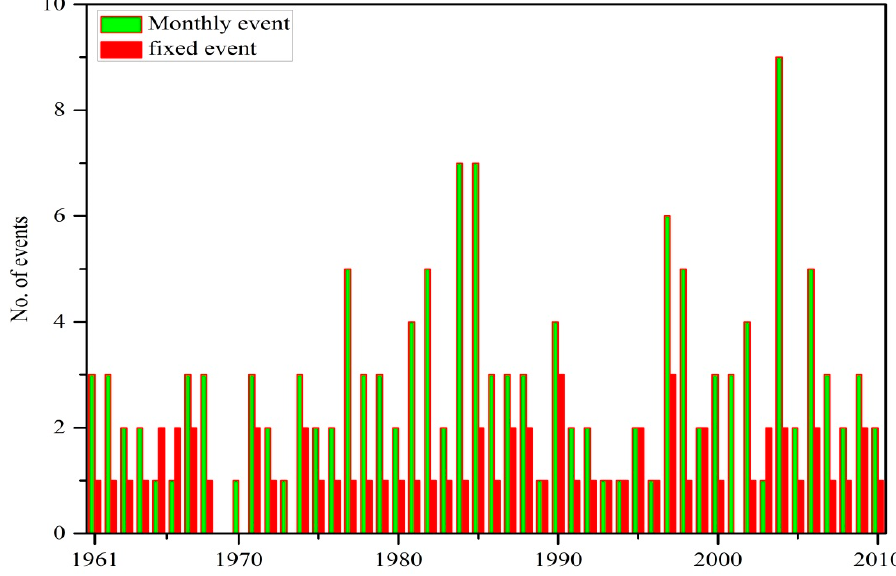
Figure 21. Annual number of drought events in Zone I.